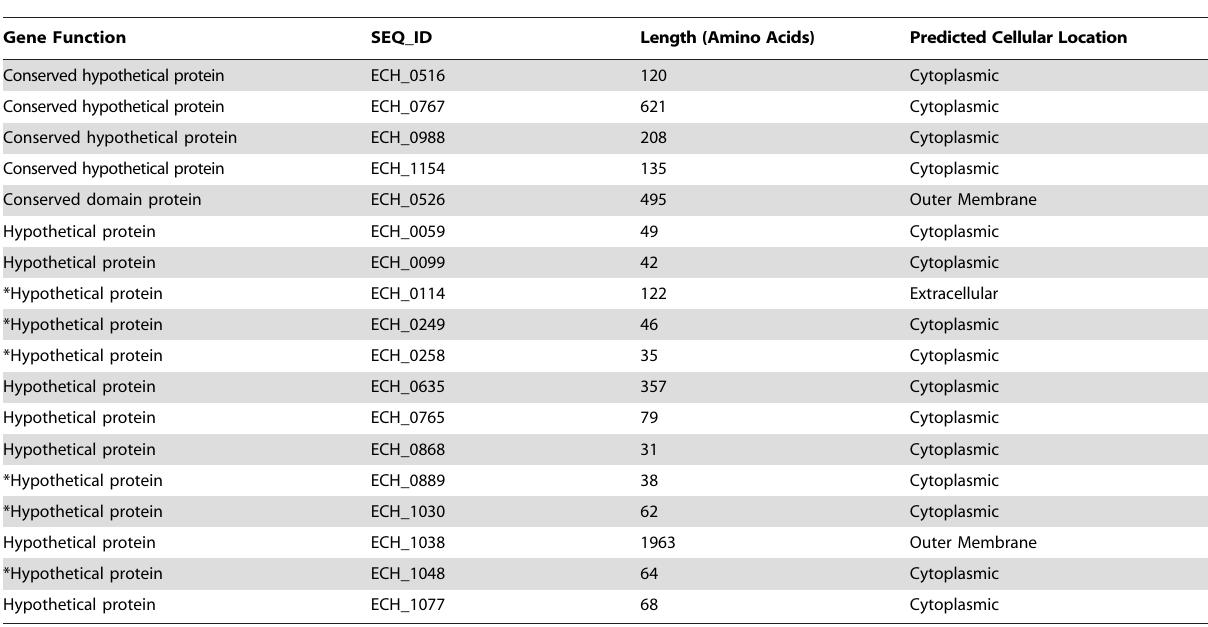
Table 3. Hypothetical genes expressed only in tick (AAE2 and ISE6)